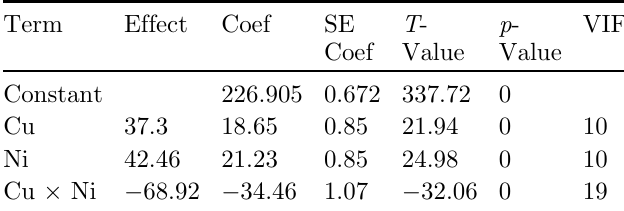
Table 4. Coded coef fi cients.